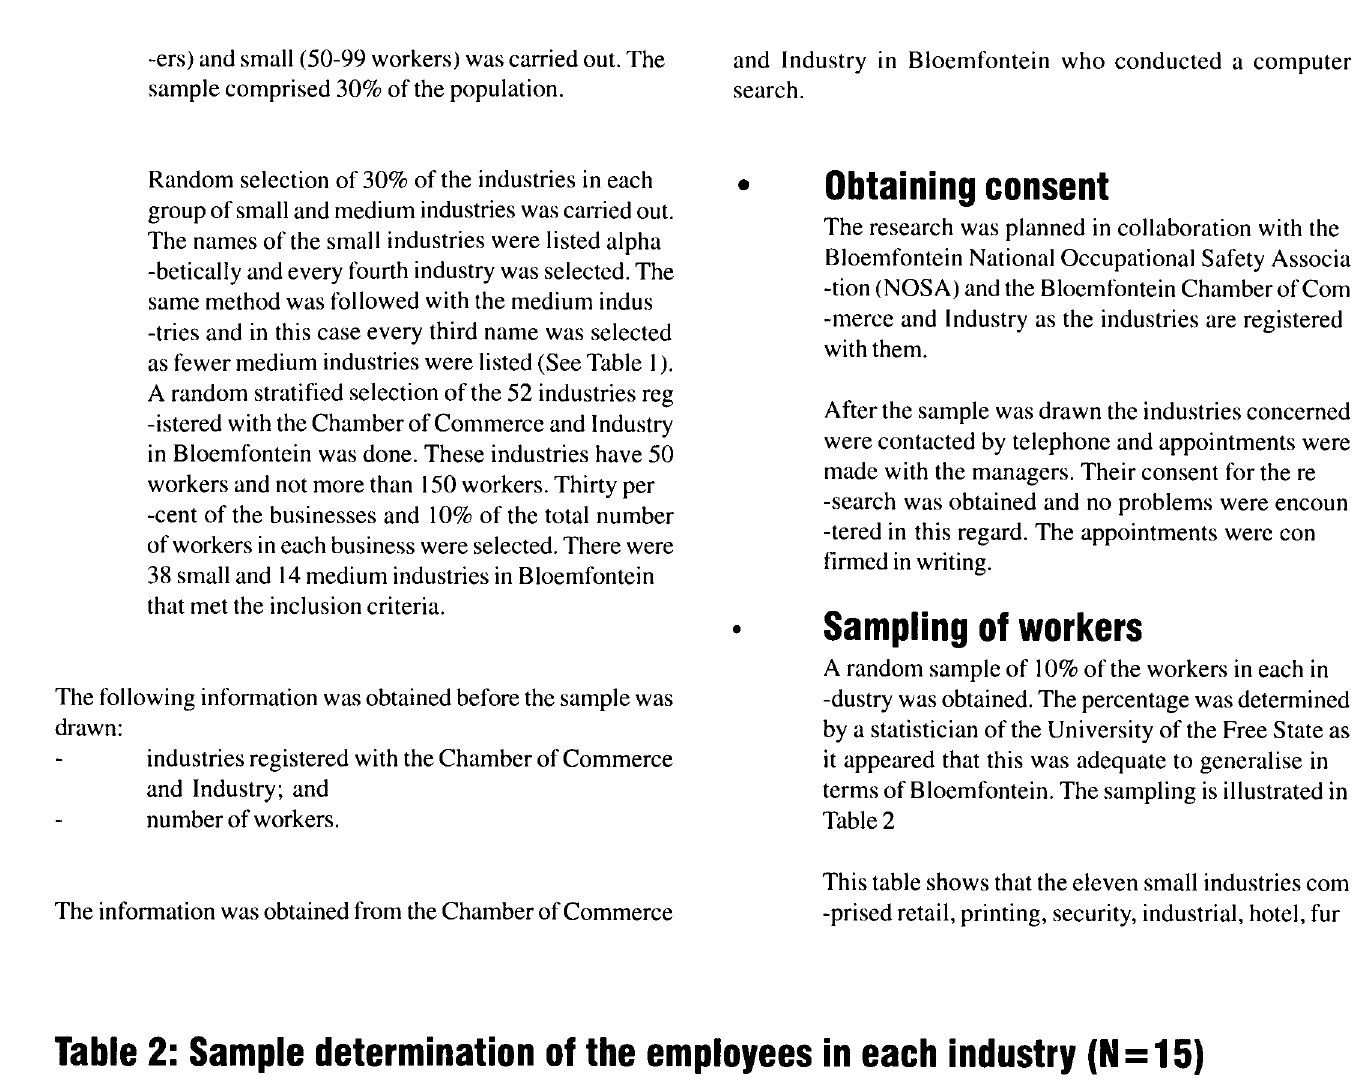
Table 2: Sample determination of the employees in each industry (N=15) TYPE OF